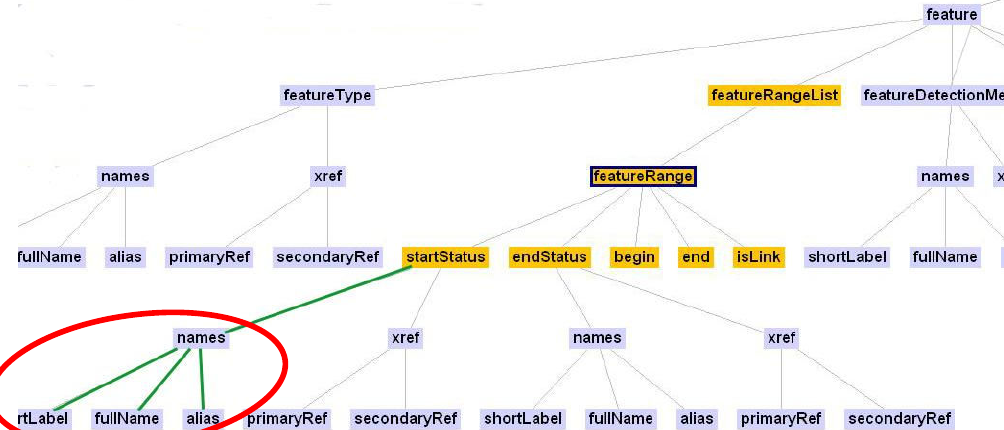
Figure 6: Partial view of DescribeX, showing incoming summary structure for featureRange